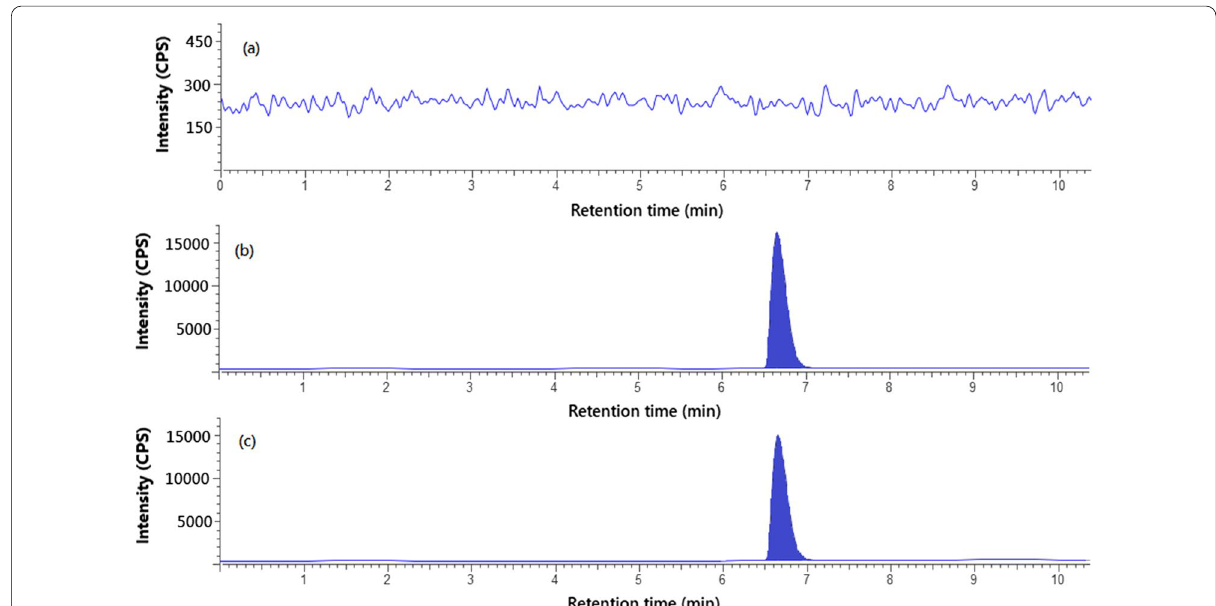
Fig. 2 Overlay MRM signal of a Blank, b standard solution of EMS and c spiked sample of DAPO with EMS